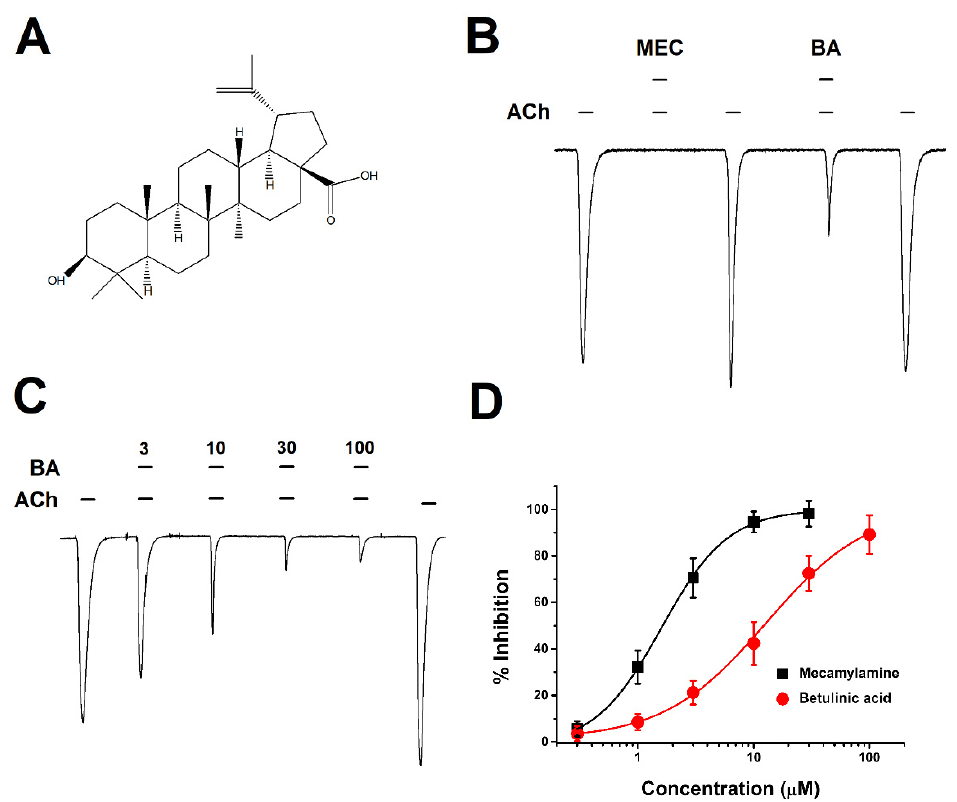
Figure 1. Chemical structure of betulinic acid (BA) and activation manner on bovine α 3 β 4 nicotinic acetylcholine receptors expressed in Xenopus oocytes. ( A ) Structure of BA. ( B ) Inhibition of I ACh on bovine α 3 β 4 nAChRs by mecamylamine (MEC), a nicotinic acetylcholine receptor antagonist, and BA. ACh, MEC, and BA were administered at 2 mL per min. The applied concentration of ACh was 100 µ M. MEC and BA were administered at 10 µ M. The trace indicated inward current in the result of a co-applied and induced reversible inward current ( n = 6–8 from four different frogs). ( C ) Concentration-relationship results induced by co-treatment with ACh and BA for α 3 β 4 nAChRs. The applied ACh concentration was fixed at 100 µ M ( n = 8–10 from five different frogs). ( D ) The inward current induced by the concentration-relationship of BA and MEC. The inhibition percentage curve of BA and MEC in α 3 β 4 nAChRs was fitted with the Hill equation. Each point represents the mean ± SEM ( n = 7–9/group). The oocyte voltage-clamp holding potential was − 80 mV.